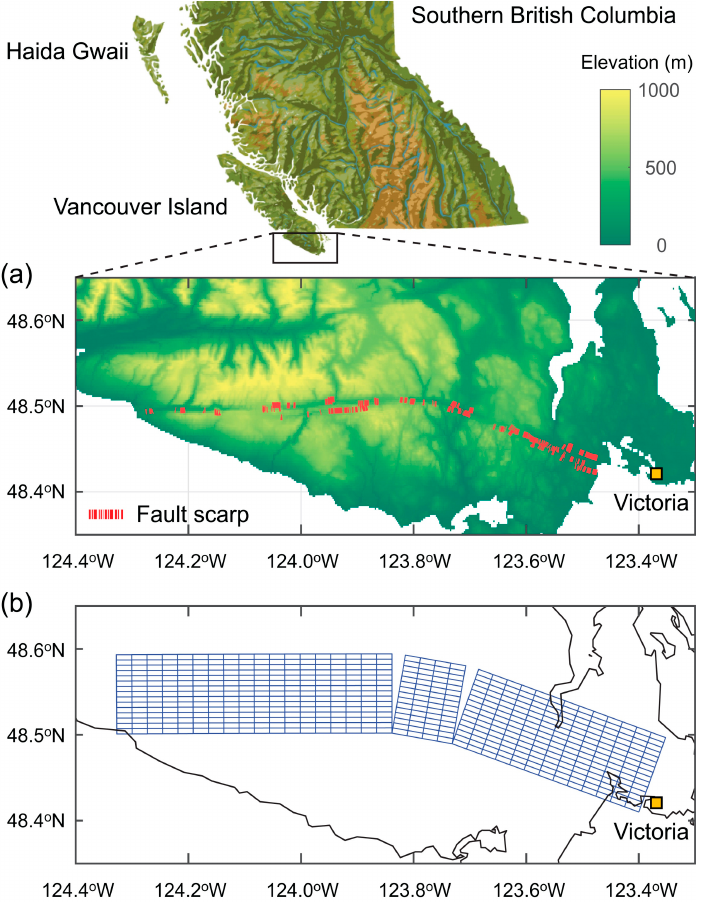
Figure 2. ( a ) Topographical characteristics of the southern Vancouver Island and ( b ) fault plane model of the Leech River Valley Fault. The fault scarp is based on [25].